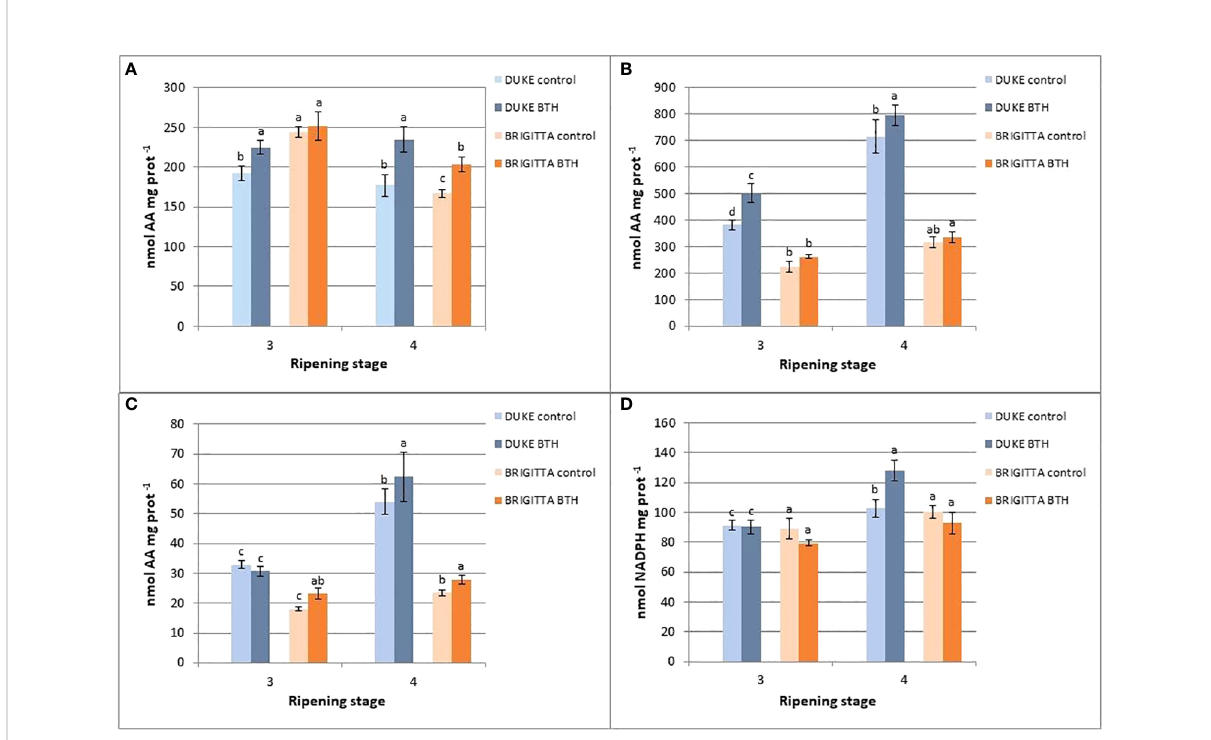
FIGURE 5 Effect of BTH on activities of (A) APX, (B) MDHAR, (C) DHAR and (D) GR in cv ‘ Duke ’ and ‘ Brigitta ’ at two ripening stages. Values represent means ± SE (n = 6). Different letters indicate statistical differences (p ≤ 0.05) among ripening classes and between treatments, for each